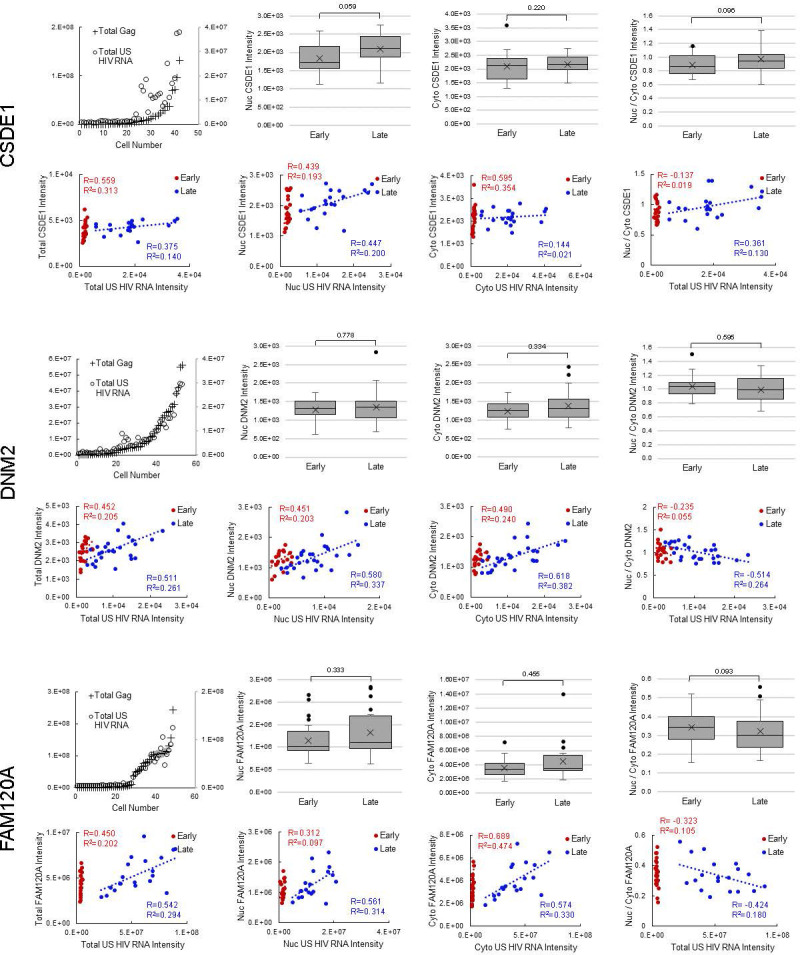
Host protein expression and cellular distribution.Data displayed for all 12 host proteins analyzed by fluorescence in situ hybridization/immunofluorescence (FISH/IF). The host protein intensities in early and late cells for each host protein, in the nucleus and the cytoplasm are plotted. A Student’s t-test is applied to determine if the host protein intensities in early cells are significantly different from those in late cells. The ratios of nuclear to cytoplasmic (nuc/cyto) host protein intensity for early and late cells are plotted (nuclear plus perinuclear [nuc+peri] for MBOAT7). A Student’s t-test measures significant differences in the cellular distribution between the sub-groups for each host protein. For each cell in the early and late cell sub-groups, the intensity of unspliced (US) HIV RNA vs the intensity of the host protein is plotted. Values for the nucleus and the cytoplasm are in separate graphs. Linear regressions (R2) are fit to each early and late, nuclear and cytoplasmic sub-group and the Pearson’s correlation coefficient (R) calculated. This demonstrates the extent of correlation between US HIV RNA expression and the expression of each host protein. Total cellular US HIV RNA intensities vs host protein nuc/cyto or nuc+peri/cyto ratios. This demonstrates the extent of correlation of host protein cellular distribution with US HIV RNA expression. Related to Figure 5 and Figure 5—source data 1.